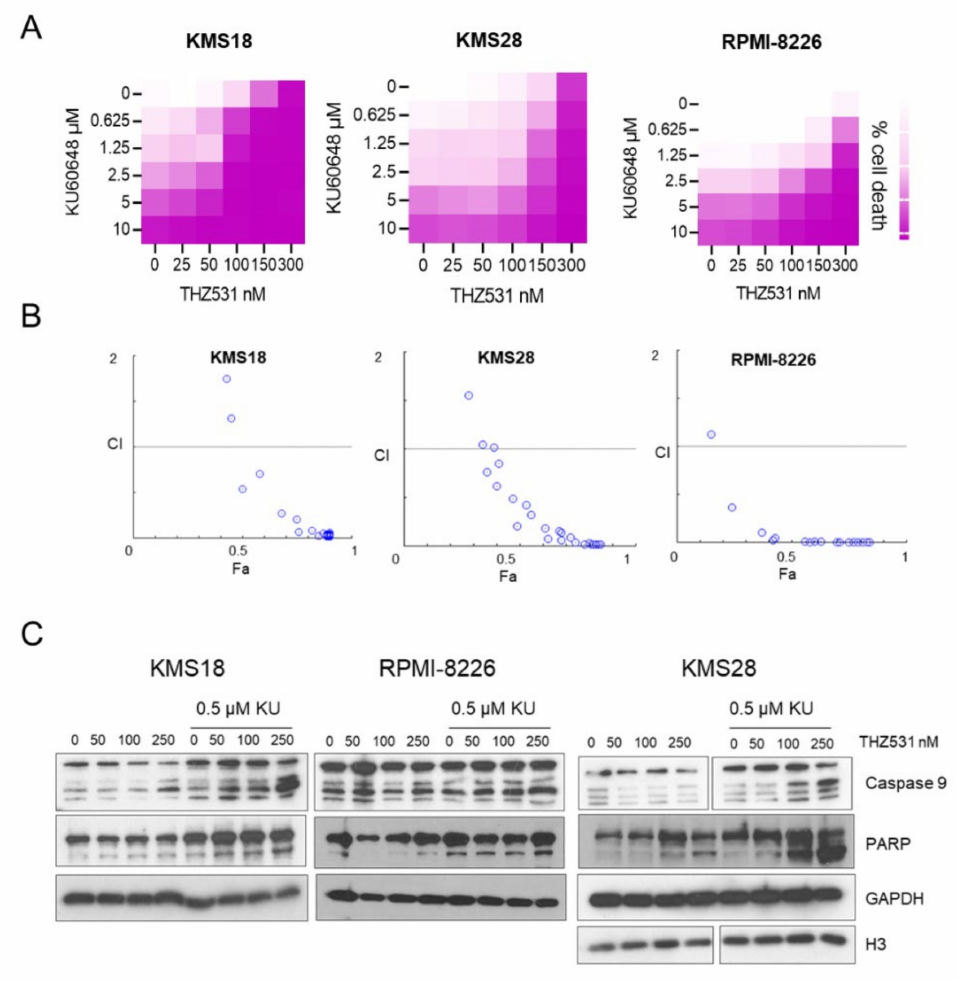
Figure 3. Synergistic effect of DNA-PK inhibitor KU-0060648 with THZ531 ( A ) MTT assay to predict synergistic growth inhibition of KMS18, KMS28, and RPMI-8226 MM cells in the presence of THZ531 and DNA-PK inhibitor KU-0060648. ( B ) Synergy and CI prediction of combination treatment. Combi- nation index (CI) defines interaction between THZ531 and KU-0060648 plotted as a fraction of cell viability. CI < 1, CI = 1, and CI > 1 represent synergism, additive, and antagonism, respectively, of the two compounds. ( C ) Immunoblotting for cleaved Caspase-9 and cleaved PARP in KMS18, KMS28, and RPMI-8226 treated with increasing doses of THZ531 (0, 50, 100, 250 nM) alone or in combination with 0.5 µ M KU-0060648. GAPDH and H3 were used as loading